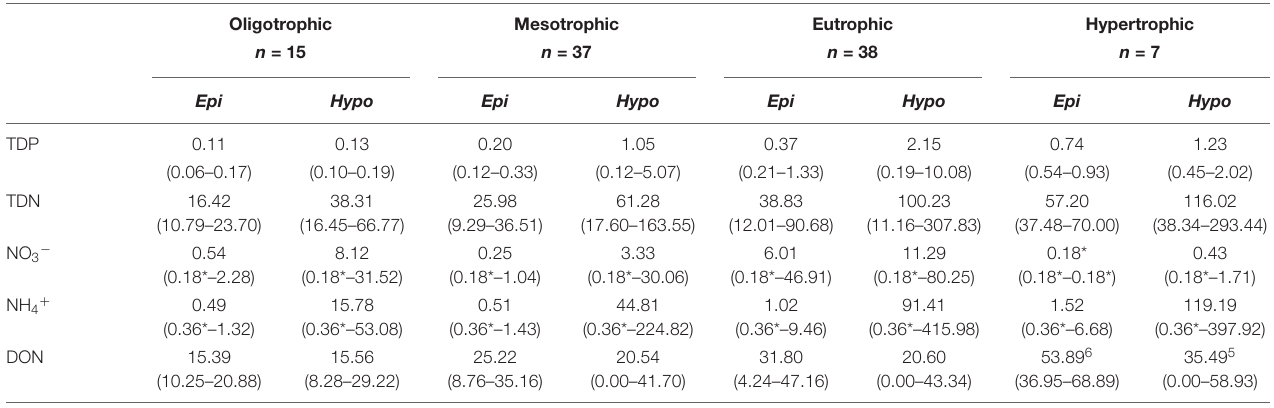
TABLE 6 | Epilimnetic and hypolimnetic dissolved nutrient chemistry from the 27 reservoirs sampled during 2018 summer stratification. Oligotrophic Mesotrophic Eutrophic Hypertrophic